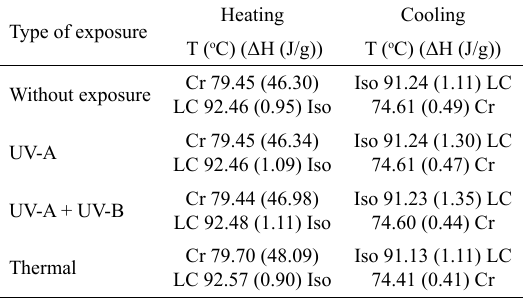
Figure 5. DSC thermogram of the second heating-cooling run with a heating rate of 5 ºC/min for LC without exposure to the test conditions. Table 1. Values determined for the temperature (T) and variation in enthalpy (ΔH) by DSC in the second heating-cooling run for LC without exposure and samples exposed to the respective test conditions for 1000 h.